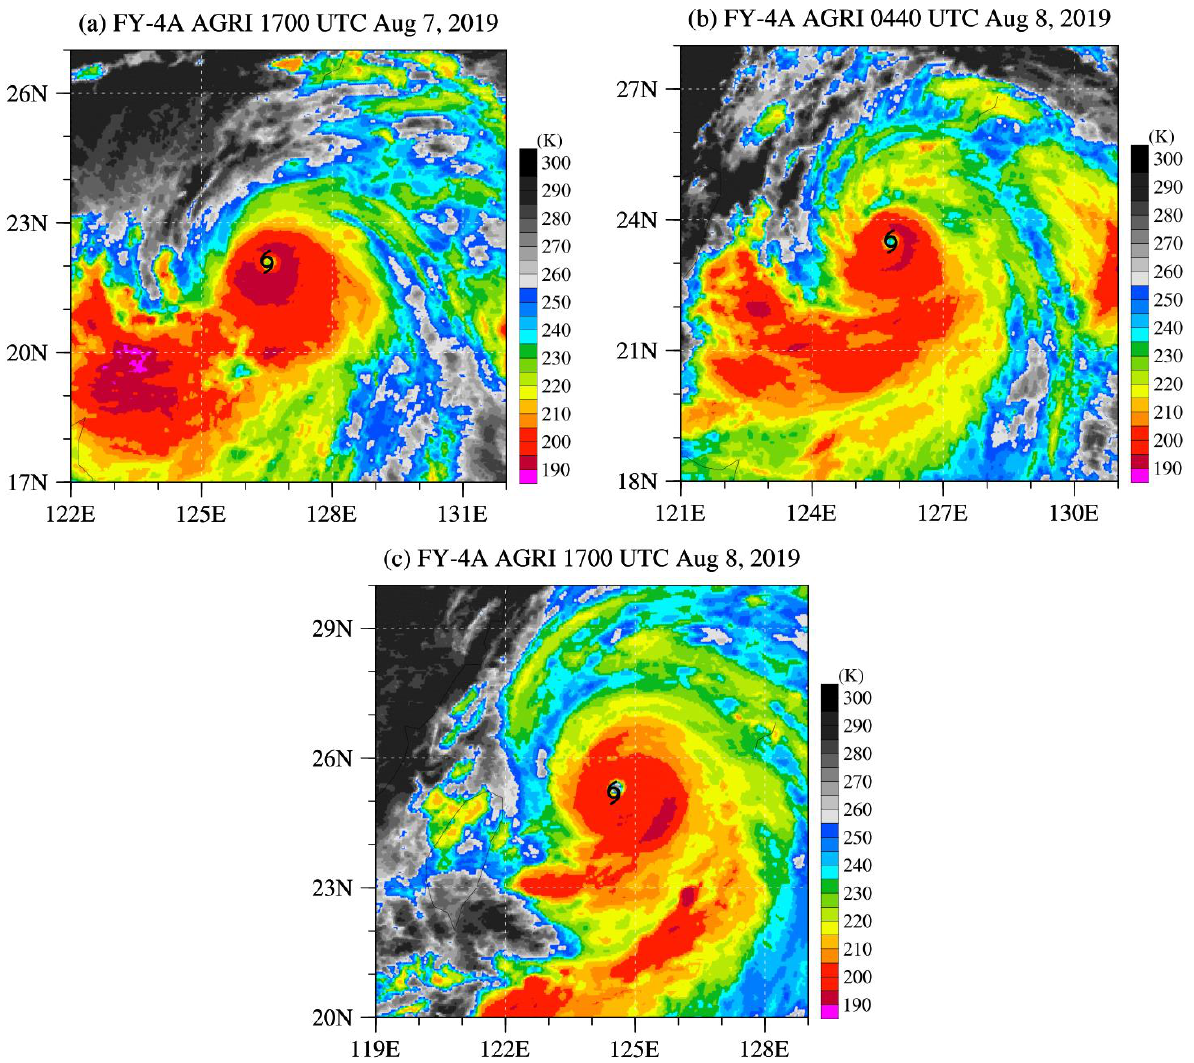
Figure 10. Spatial distributions of FY-4A AGRI channel 12 brightness temperatures (unit: K) at ( a ) 1700 UTC on 7 August 2019, ( b ) 0440 UTC on 8 August 2019, and ( c ) 1700 UTC on 8 August 2019. The black typhoon symbols stand for the best track centers of Typhoon Lekima in Figure 9.